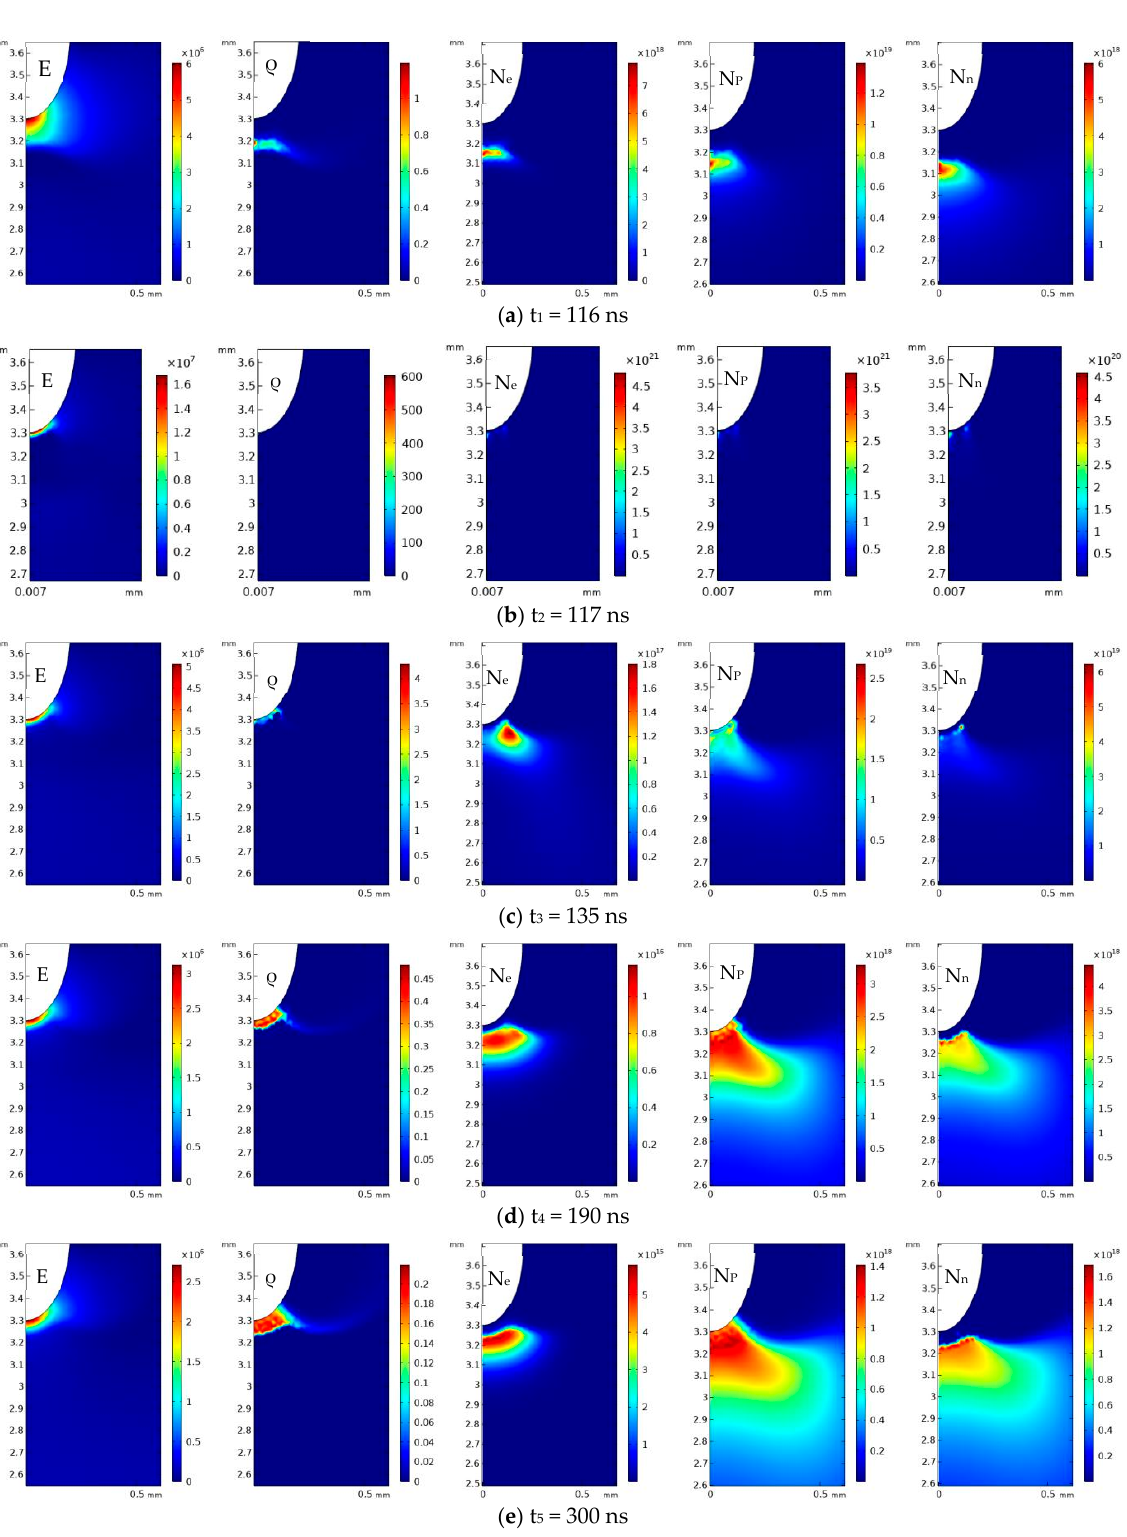
Figure 4. Corona discharge morphology at different times. In the early stages of corona discharge development (t = 116 ns), the maximum rod field strength is 60 kV/cm, which is greater than the initial breakdown field strength of the air negative bar-plate gap. Next, the air ionizes positive ions and electrons rapidly under the action of an applied electric field, and the number density of positive ions and elec- trons in the gap increases gradually. The positive ions on the surface of the plate move to